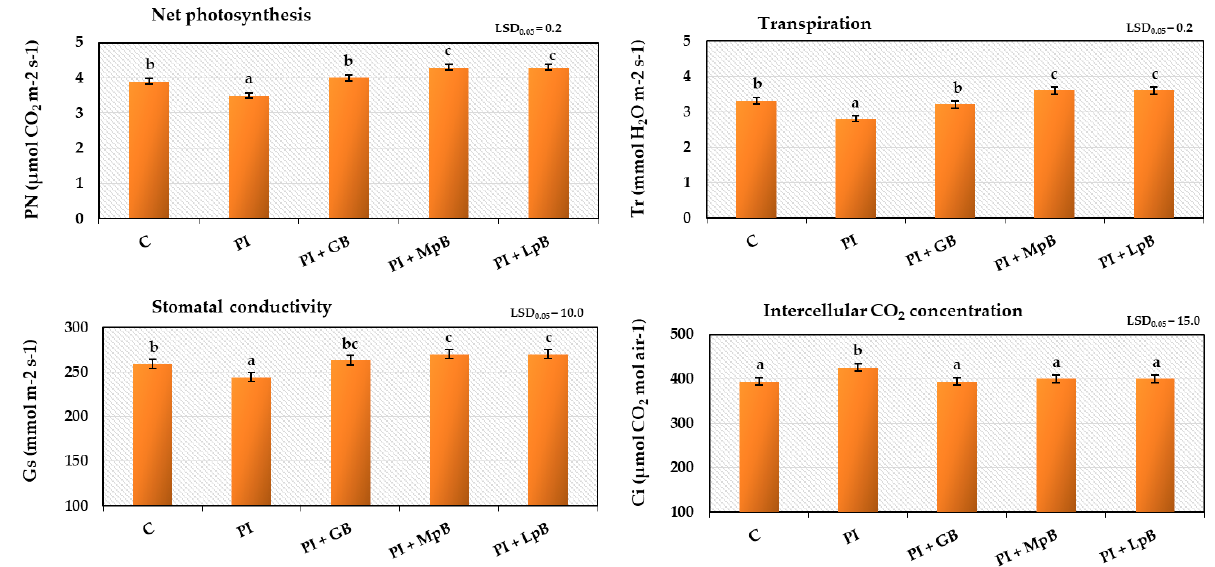
Figure 6. Gas exchange in leaves obtained from Impresja seed potatoes treated with biopreparations and inoculated with phytopathogens. C—control potato, not treated with any biopreparations and not inoculated with pathogens; PI—potato sample only inoculated with pathogens; PI + GB—potato sample treated with aqueous garlic extract biopreparation and inoculated with pathogens; PI + MpB—potato sample treated with M. pulcherrima TK1 biopreparation and inoculated with pathogens; PI + LpB—potato sample treated with L. plantarum KB2 LAB 03 biopreparation and inoculated with pathogens. Means marked with the same letters (a–c) do not differ statistically at the significance level p = 0.05; LSD—least significant difference.